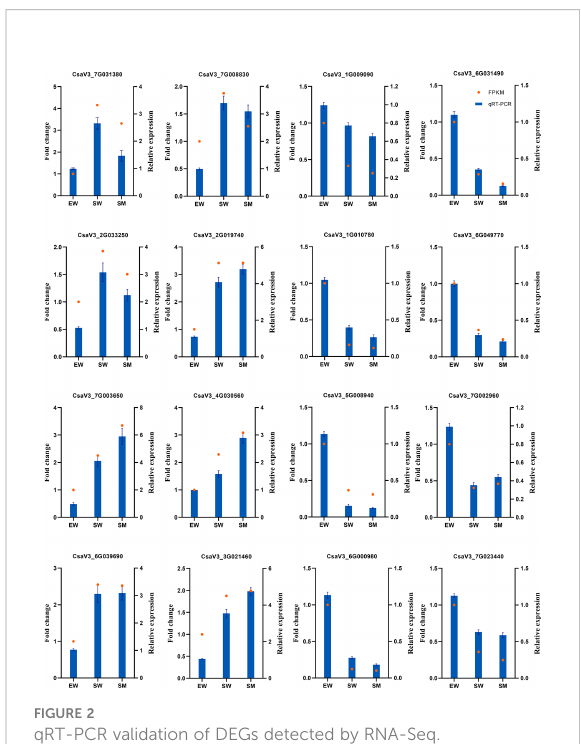
FIGURE 2 qRT-PCR validation of DEGs detected by